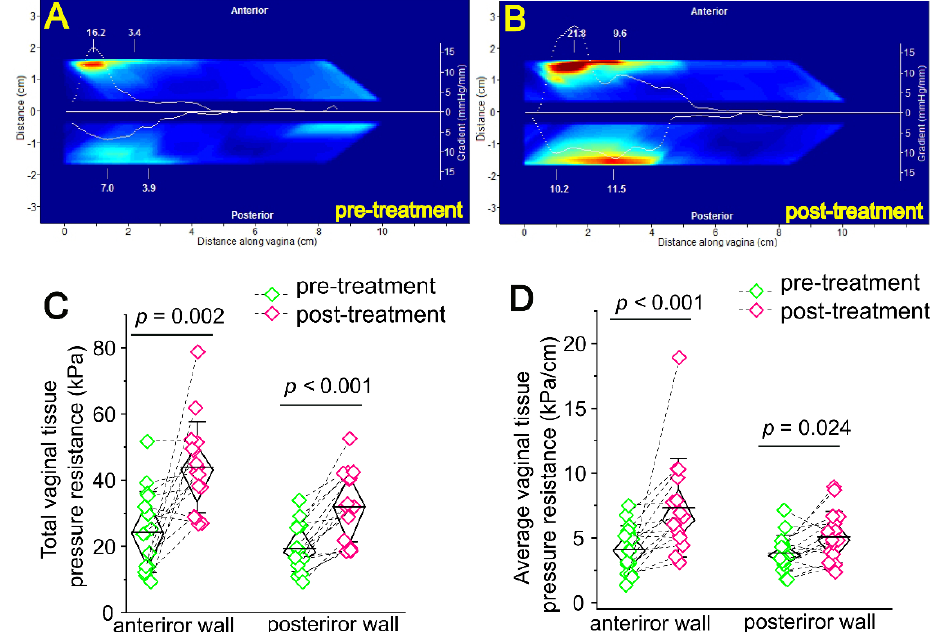
Figure 1. Fractional CO 2 laser treatment improves vaginal tissue tightening in patients with VL. ( A , B ), Tactile images showing pressure gradients for VTI probe insertion for a 42 year old female subject pre-treatment and 12 months post-treatment. A pressure resistance curve (white) was generated during each measurement and displayed in the VIT image. ( C ) Quantitative analysis of total vaginal tissue pressure resistance of the anterior and posterior vaginal walls (kPa). The total area under the pressure curve was computed to determine the maximal pressure, e.g., total vaginal tissue pressure resistance, in both anterior and posterior vaginal walls. ( D ) The average vaginal tissue pressure resistance crossing anterior and posterior vaginal walls was determined by the ratio of total vaginal tissue pressure resistance to the length of the vaginal wall with detectable pressure in the curve (kPa/cm). Dotted lines connect VTI data points before and after treatment for the same subject; diamond boxes represent median (IQR), and whiskers represent SD. Statistical analysis was performed using a Wilcoxon signed-rank test (two-sided).